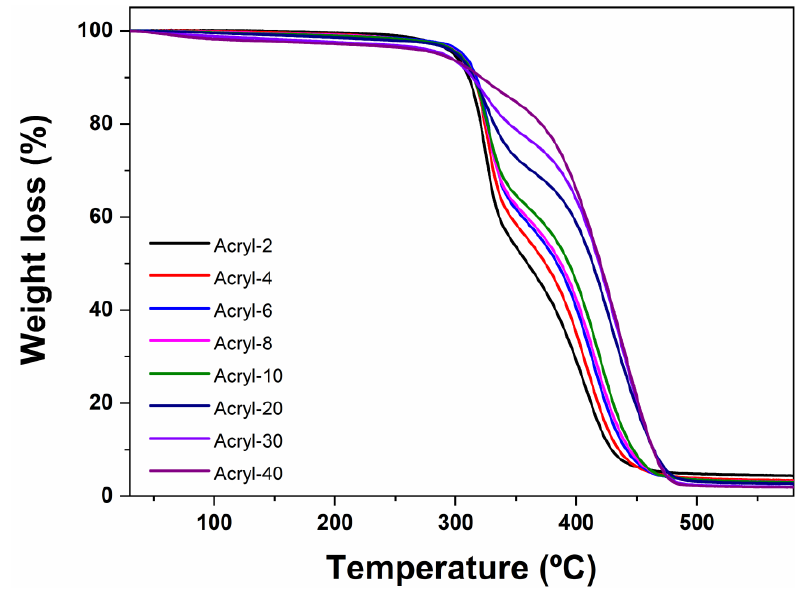
Figure 2. Thermal stability analysis of acrylic PSA films for HEA content.